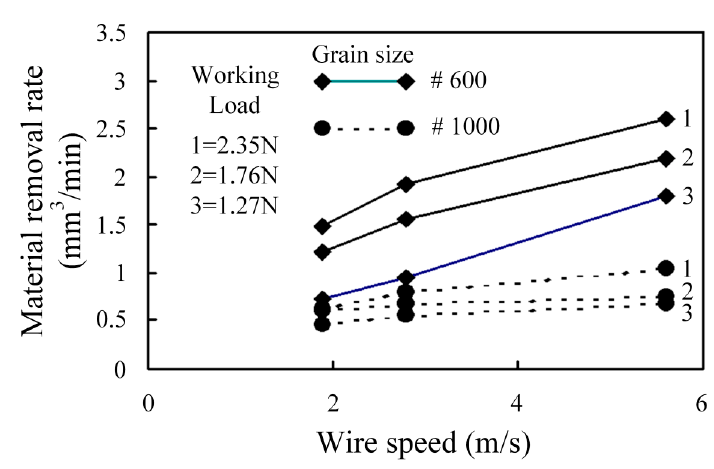
Figure 7. Comparison of MRR for #600 and #1000 grains.